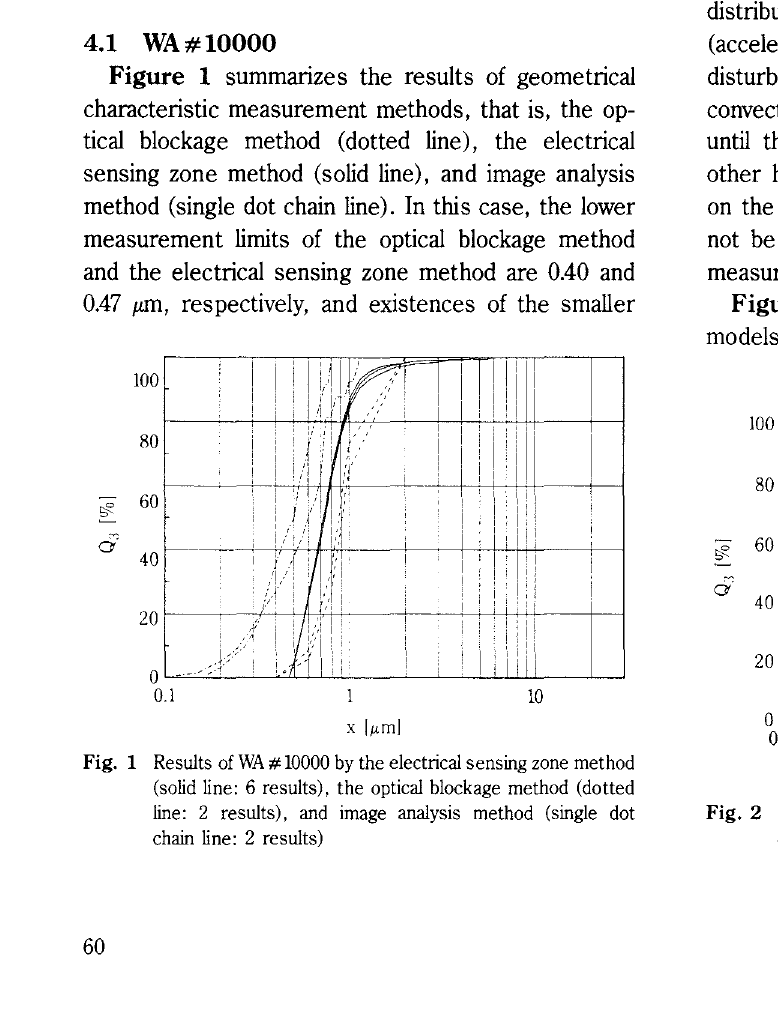
Fig. 2 Results of WA # 10000 by centrifugal sedimentation light extinction method (2 models of the same maker)